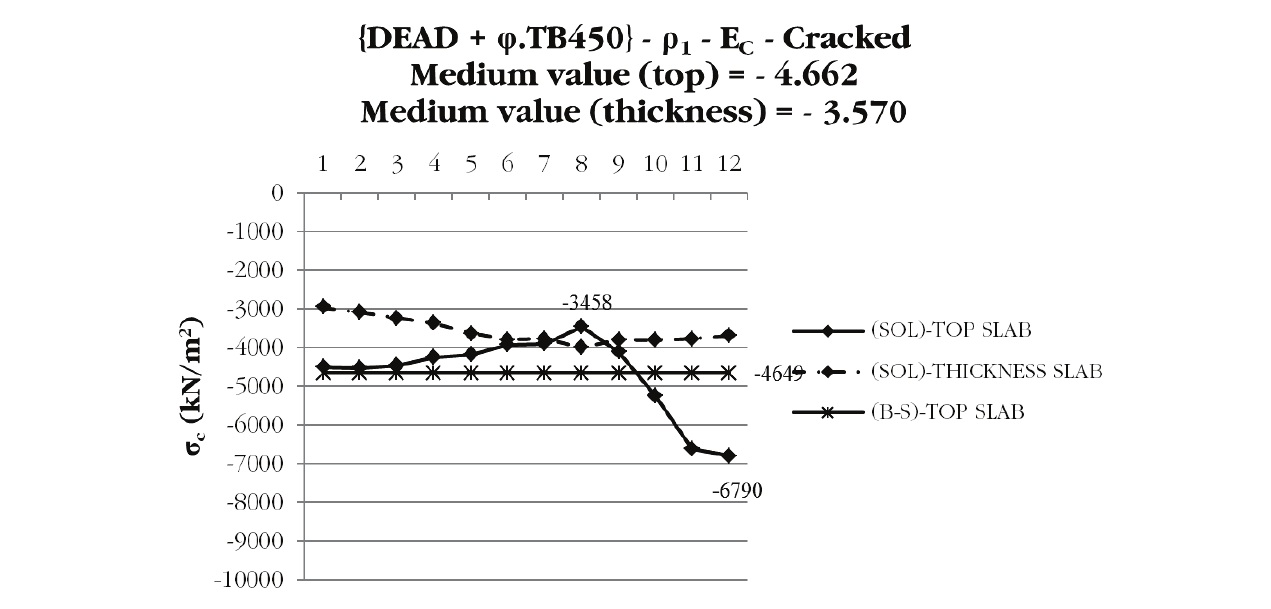
Figure 16 – Distribution of the longitudinal compressive stress – {DEAD + φ .TB450}, cracked